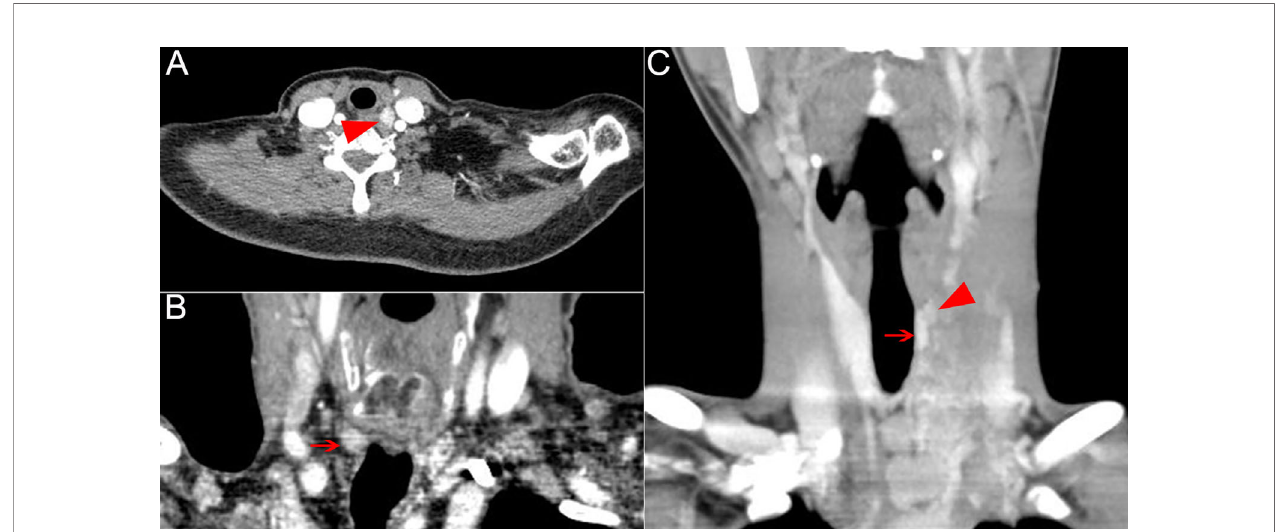
FIGURE 2 | Recurrent nodal disease in RLNIZ diagnosed by enhanced computer tomography. (A) Recurrent nodal disease in RLNIZ in case 1. (B) Residual thyroid tissue in RLNIZ without tumor foci. (C) Recurrent nodal disease and residual thyroid tissue with tumor foci in RLNIZ in case 4. Red arrowhead: recurrent nodal disease; red arrow: residual thyroid tissue. RLNIZ, recurrent laryngeal nerve inlet zone.